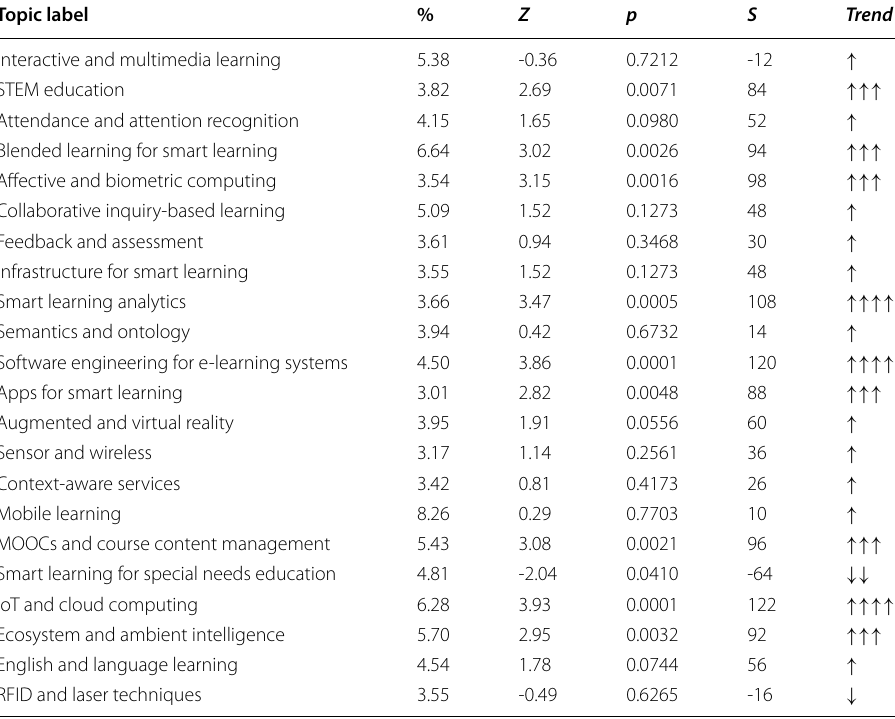
Table 6 Results of the STM model with 22 topics Topic label % Z p S Trend Interactive and multimedia